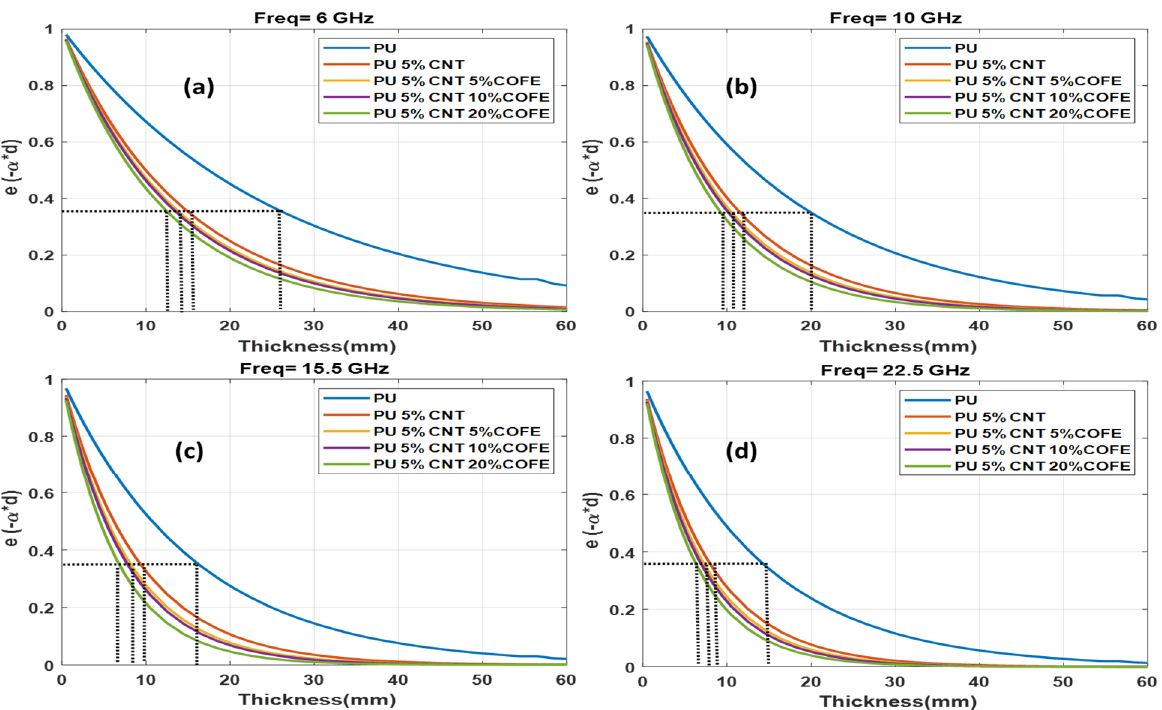
Figure 11. Comparison of attenuation factor for PU, PU 5%CNT, PU + 5%CNT + (5%, 10%, 20%) CoFe at different center frequencies ( a ) 6 GHz ( b ) 10GHz ( c ) 15.5 GHz ( d ) 22.5 GHz.